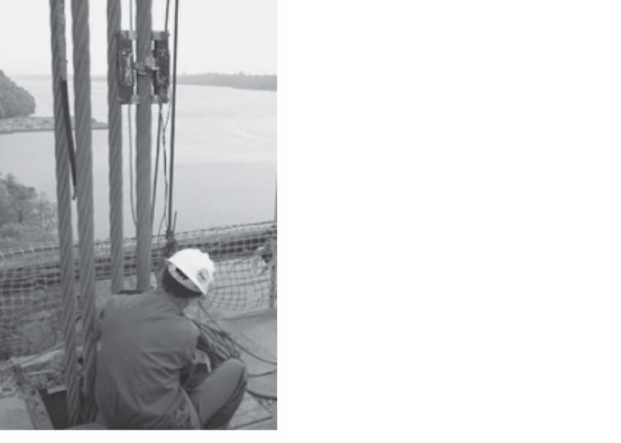
Figure 25. Application of MsS for George Washington Bridge, New York City